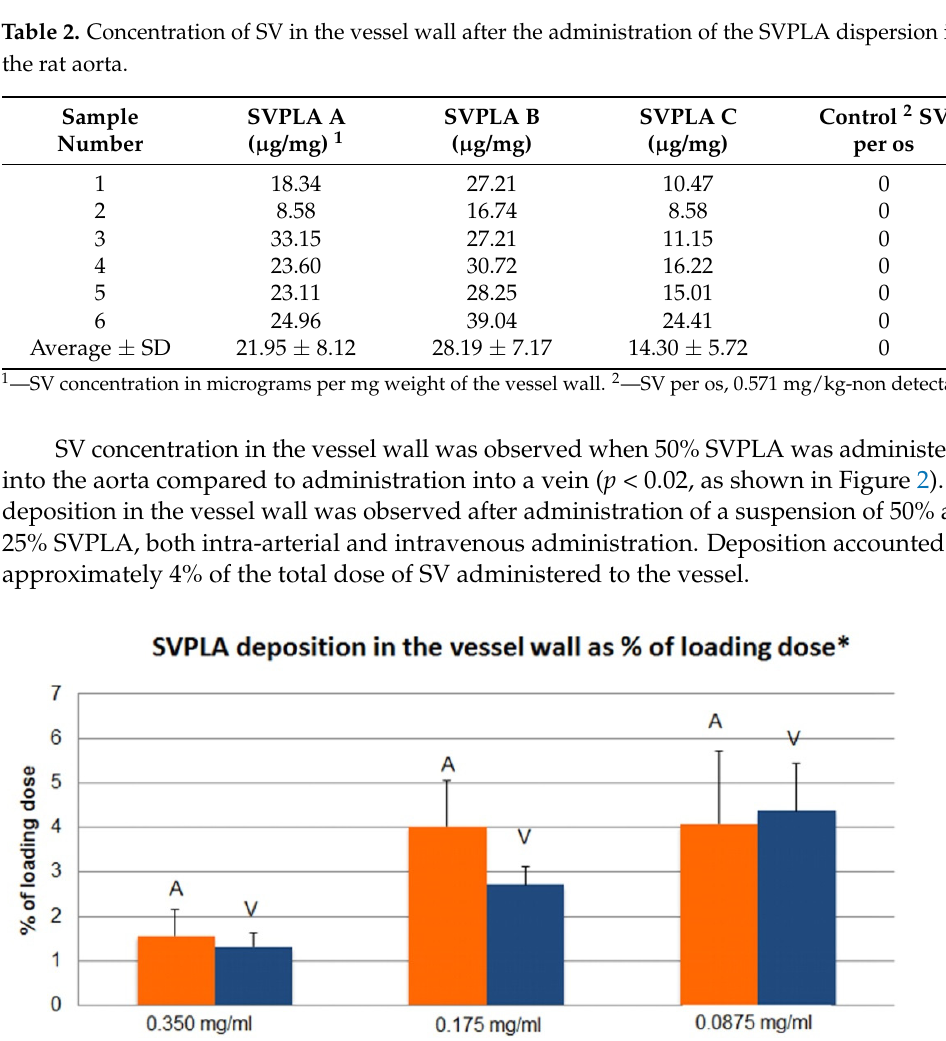
Table 2. Concentration of SV in the vessel wall after the administration of the SVPLA dispersion into the rat aorta.